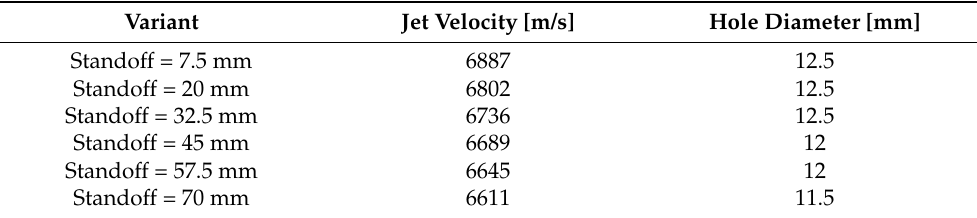
Table 9. Summary of the shaped charge jet velocity at the moment of contact with the